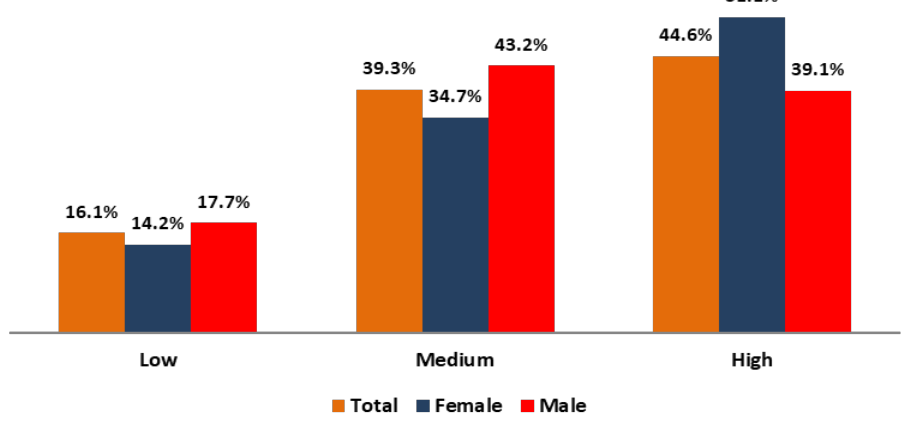
Figure 2. Prosociality levels (% by sex).